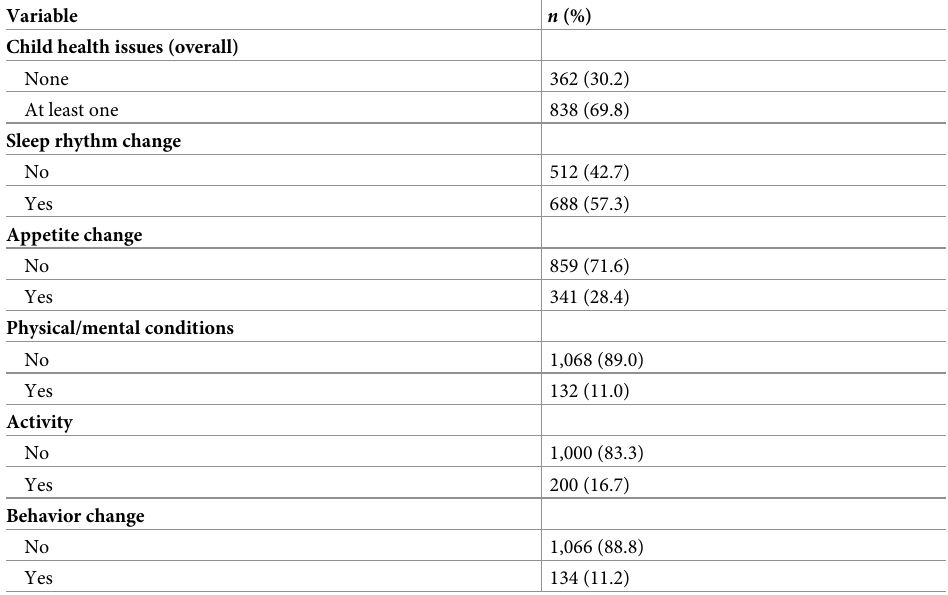
Table 2. Child health issues reported by participants ( N =